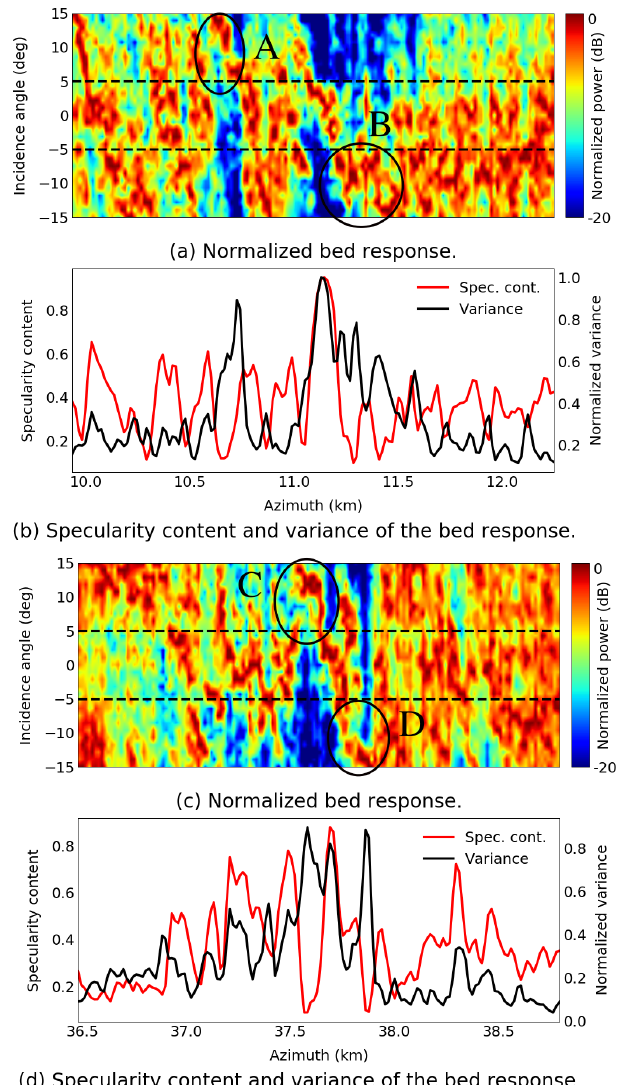
Figure 11. Specularity content and variance as measures of spec- ularity of the bed return for track 2. For comparison we take two parts of track 2 each 2.3km long. The power of the angular energy returns (a) and (c) is normalized with respect to the highest value of the distribution at each azimuth position. The area inside the dashed horizontal lines in (a) and (c) corresponds to (cid:49)θ 1